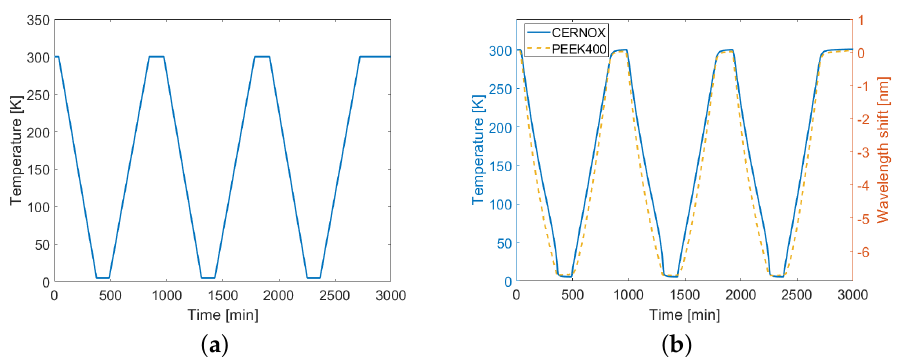
Figure 3. ( a ) Nominal thermal cycles of the cryo-cooler. ( b ) Comparison between the absolute temperatures measured with the CERNOX (left axis) and the wavelength shifts measured on the PEEK400 sample with respect to the reference temperature T 0 = 300K (right